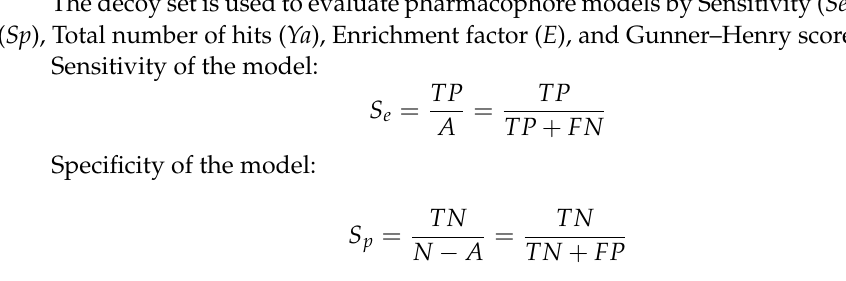
Figure 16. Parameters used for evaluating the pharmacophore Figure 16 . Parameters used for evaluating the pharmacophore model.